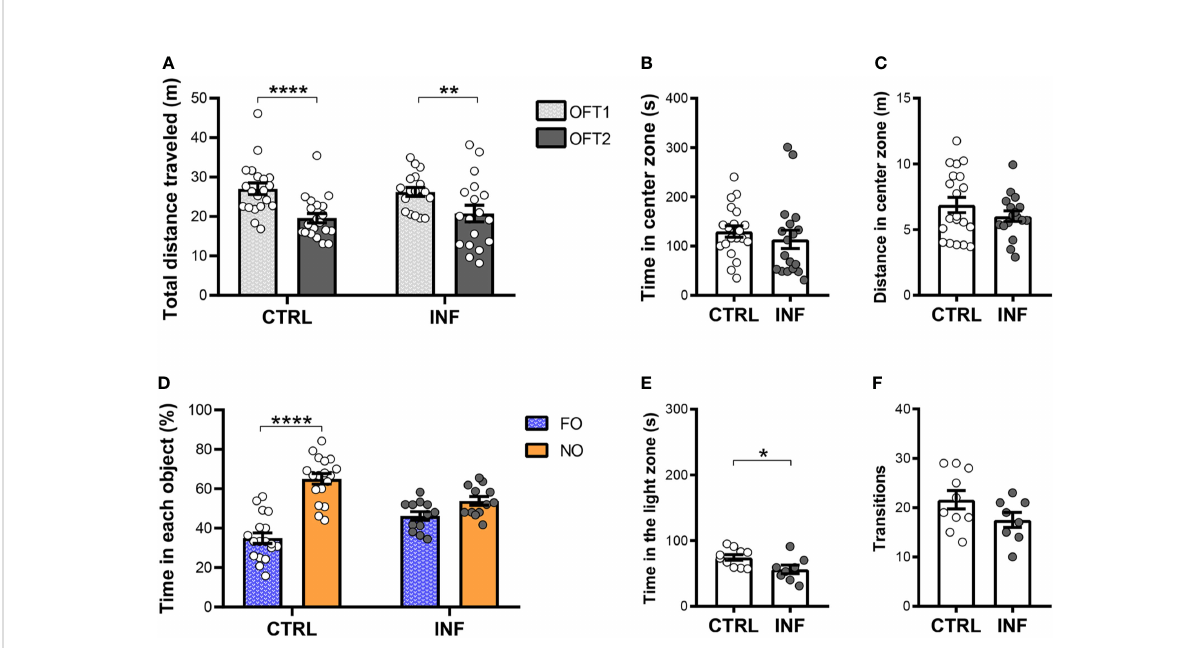
FIGURE 3 Effect of non-severe Plasmodium berghei ANKA infection in mice in behavioral performance in different paradigms 12 days after the end of treatment (dpt). (A) Total distance traveled in meters (m) in open fi eld test (OFT1 and OFT2). (B) Time in center zone (seconds, s). (C) Distance in center zone (m) in fi rst session of OFT. (D) Time in objects in percentage (%) in test session of the NORT. (E) Time in the light zone (s). (F) Numbers of transitions between light and dark side in light/dark task. CTRL (control) and INF (infected and treated) mice groups. Data points are identi fi ed as individuals ’ values. Columns represent mean ± S.E.M. Two-way RM ANOVA/Bonferroni was used for intragroup comparison of different sessions (n=18-20/group) and different objects (n=12-18/group). Two-way ANOVA was used for comparison between CTRL vs INF of OFT1 and OFT2, and the p-values were non-signi fi cant (n=18-20/group). Unpaired student t-test was used to compare control and infected group (n= 8-20/group). *p<0.05; **p<0.01;